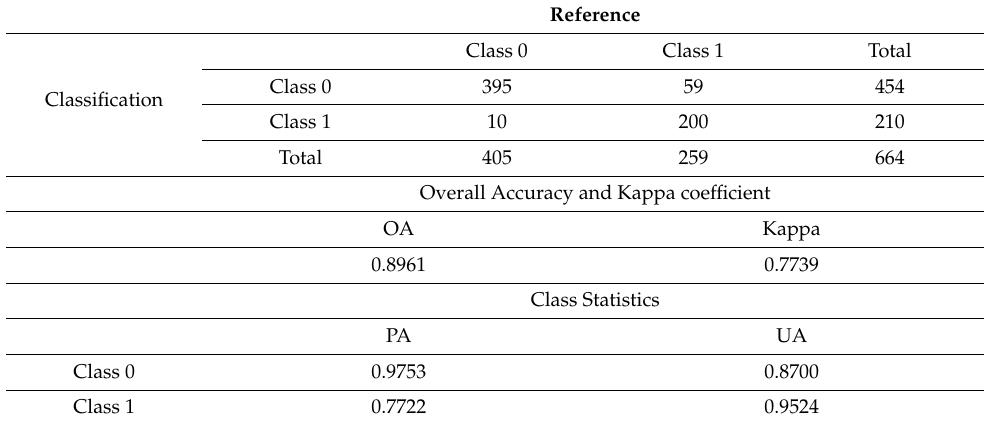
Table A7. PS + GLCM MAX + Topo classification (“scheme 3”).